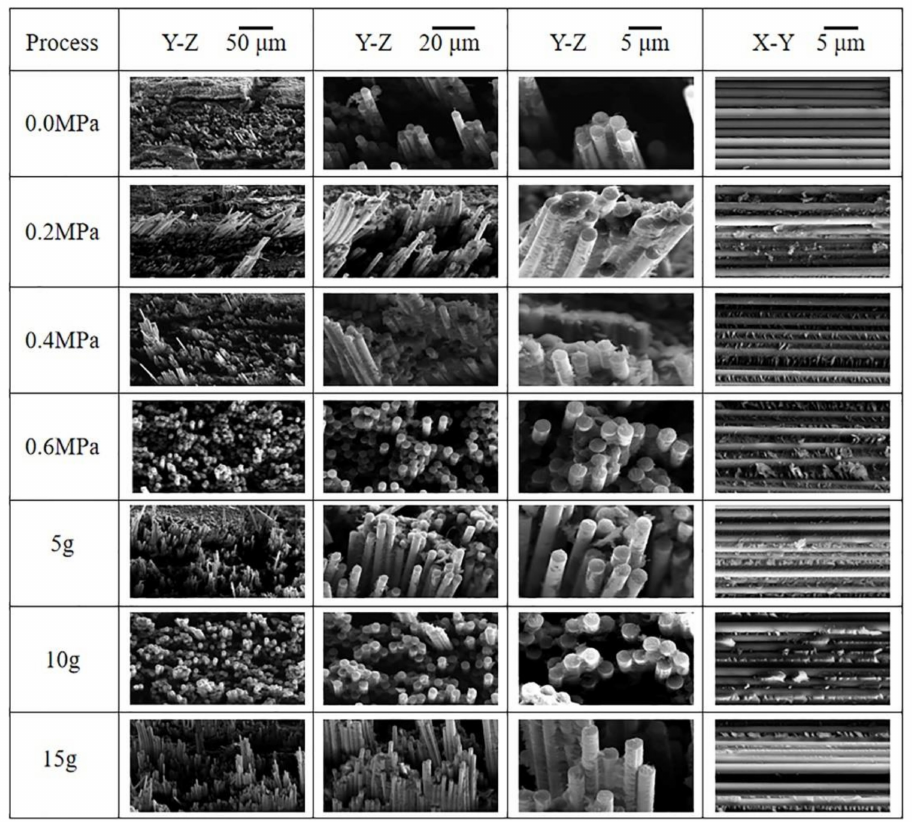
Figure 10. Representative scanning electron micrographs of vertical and horizontal fracture surfaces of composites produced by different curing